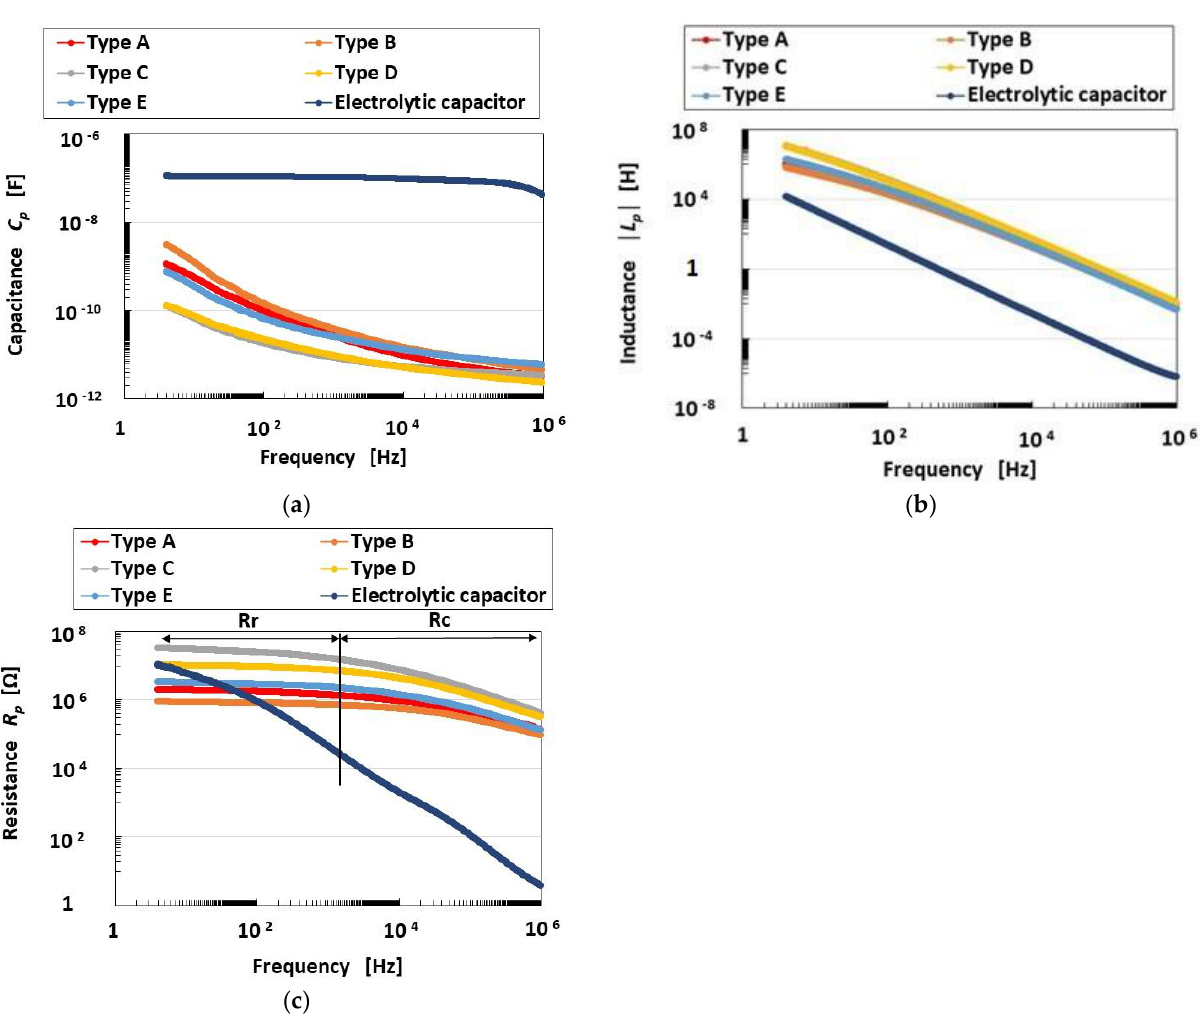
( b ) Figure 4. The tendency of impedance based on a parallel electric circuit: ( a ) electric circuit; ( b ) change of impedance based on the parallel electric circuit. In the case of X , there are also two ranges, Rr and Rc, as shown in Figure 2b. The tendency of X involves the effect of L p in contrast to that of Z : L p dominantly affects Z in range Rr so that L p increases with increasing X ; C p dominantly affects Z in range Rc so that C p increases with decreasing X . X increases in range Rr and decreases in range Rc with increasing frequency, as shown by the up-arrow c and down-arrow d, respectively, in Figure 2b. By transmitting from range Rr to range Rc, the effect of L p decreases. This ten- dency coincides with that shown in Figure 3b. Increasing X means increasing L p , as shown by the up-arrow c in range Rr in Figure 2b. Therefore, L p decreases in Types C, D, E, A,